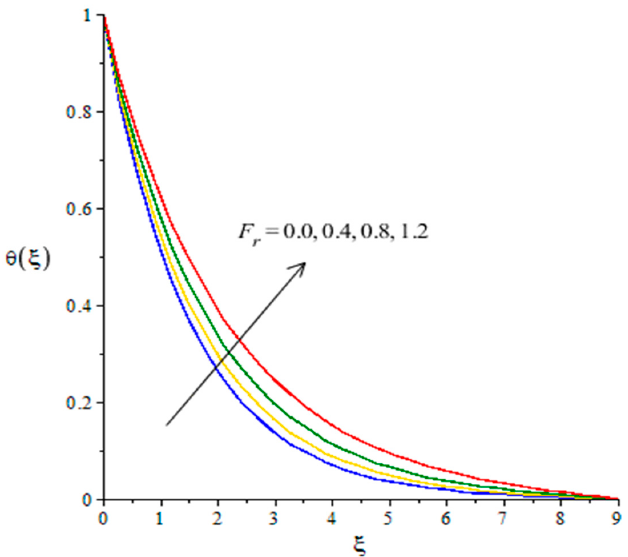
Figure 17. Variation role of θ ( ξ ) versus M 2 when m = 0.01, We = 3, Ω = 3.0, β e = 0.5, β i = 0.7, Figure 17. Variation role of 𝜃(𝜉) versus 𝑀 (cid:2870) when 𝑚 = 0.01, 𝑊𝑒 = 3,Ω = 3.0,𝛽 (cid:3032) = 0.5,𝛽 (cid:3036) = (cid:101) = 0.01, F r = 2.5, Pr = 204, Ec = 0.34, ϕ 2 = 0.0075, ϕ 1 = 0.002, ϕ 3 = 0.005. 0.7, 𝜖 = 0.01, 𝐹 (cid:3045) = 2.5, 𝑃𝑟 = 204, 𝐸𝑐 = 0.34,𝜑 (cid:2870) = 0.0075, 𝜑 (cid:2869) = 0.002,𝜑 (cid:2871) = 0.005.